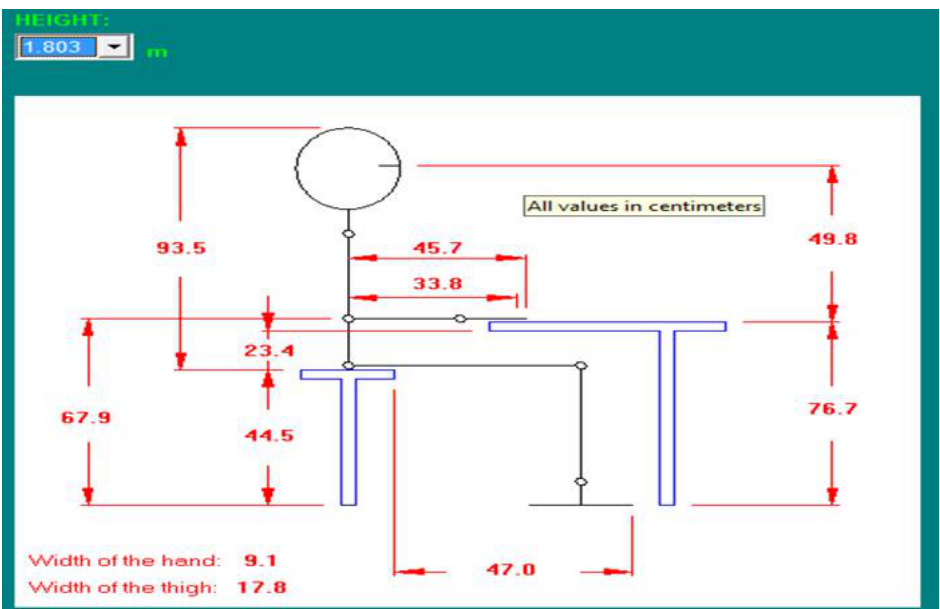
Figure 2. The position of the body of the workforce was 1.803 m in the sitting position in the Ergo Fellow program (values in centimeters). Source: (Ergo Fellow).